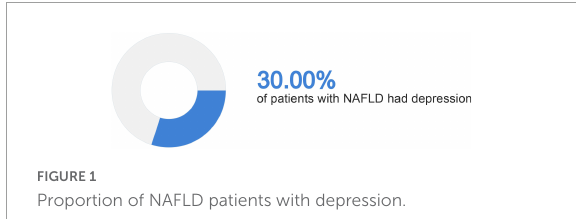
FIGURE1 Proportion of NAFLD patients with